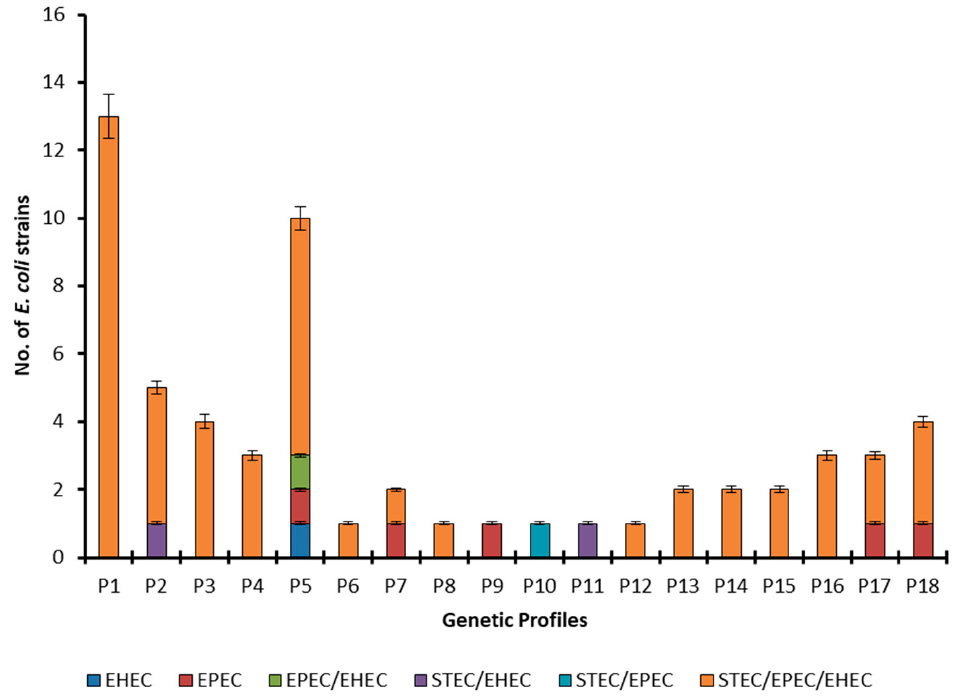
Figure 4. ERIC-PCR-based fingerprint patterns of E. coli pathotypes.